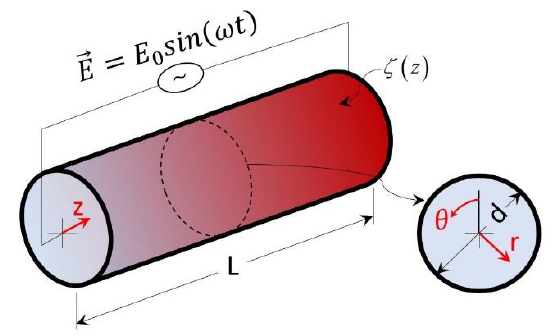
Figure 1. Schematic of a cylindrical microchannel with an associated polar coordinate system.